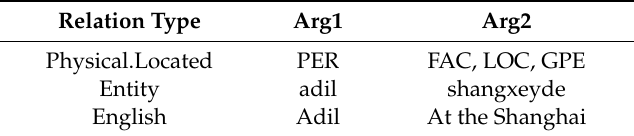
Table 6. Permissible parameter table for an example sentence.